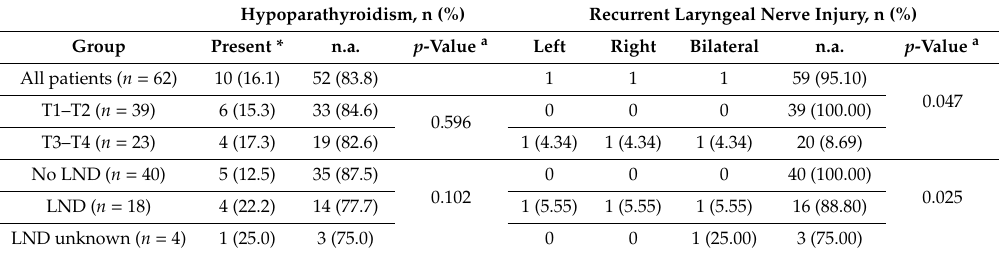
Table 3. Surgical complications.